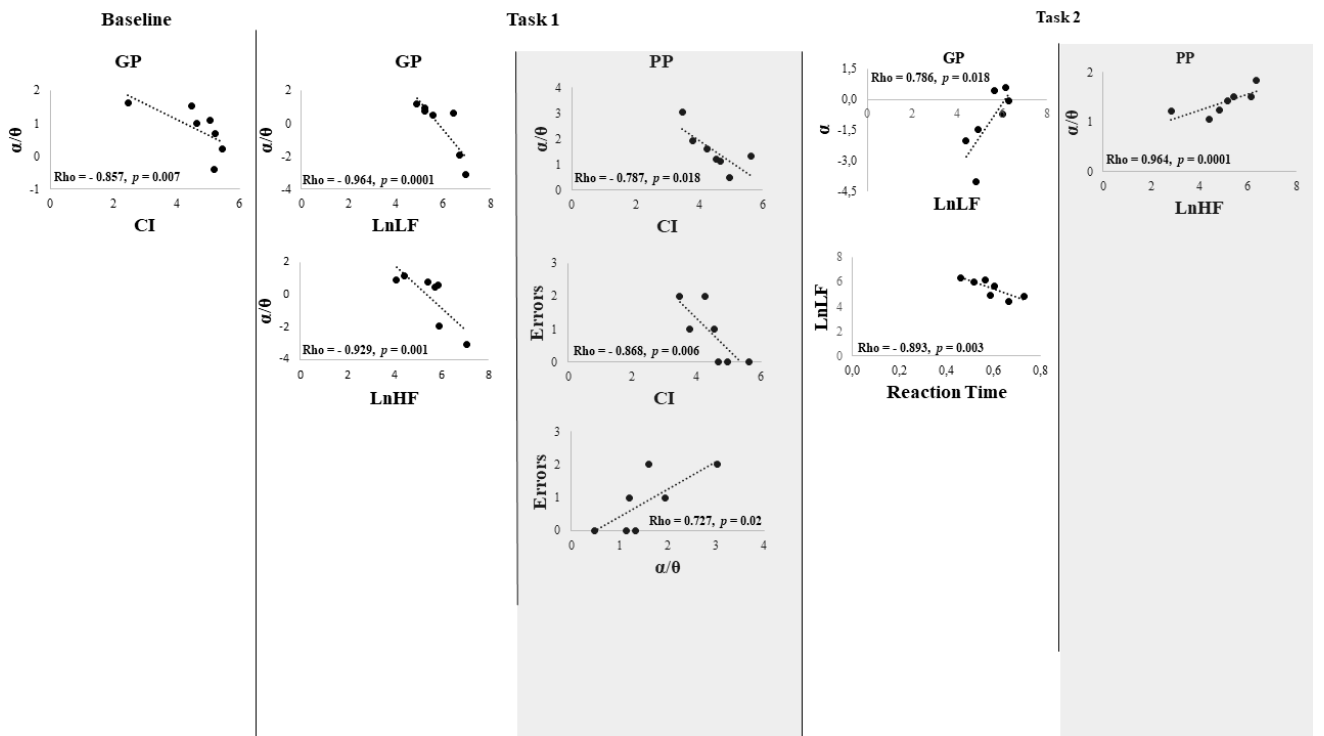
Figure 8. Scatter Plot of the correlation between HRV parameters (Complexity Index (CI), HF power (LnHF), LF power (LnLF)) and EEG α , ϑ , and α / ϑ ratio EEG powerbands of the group with Good Performance (GP) and of the group with Poor Performance (PP). The dashed line represents the tendency line.